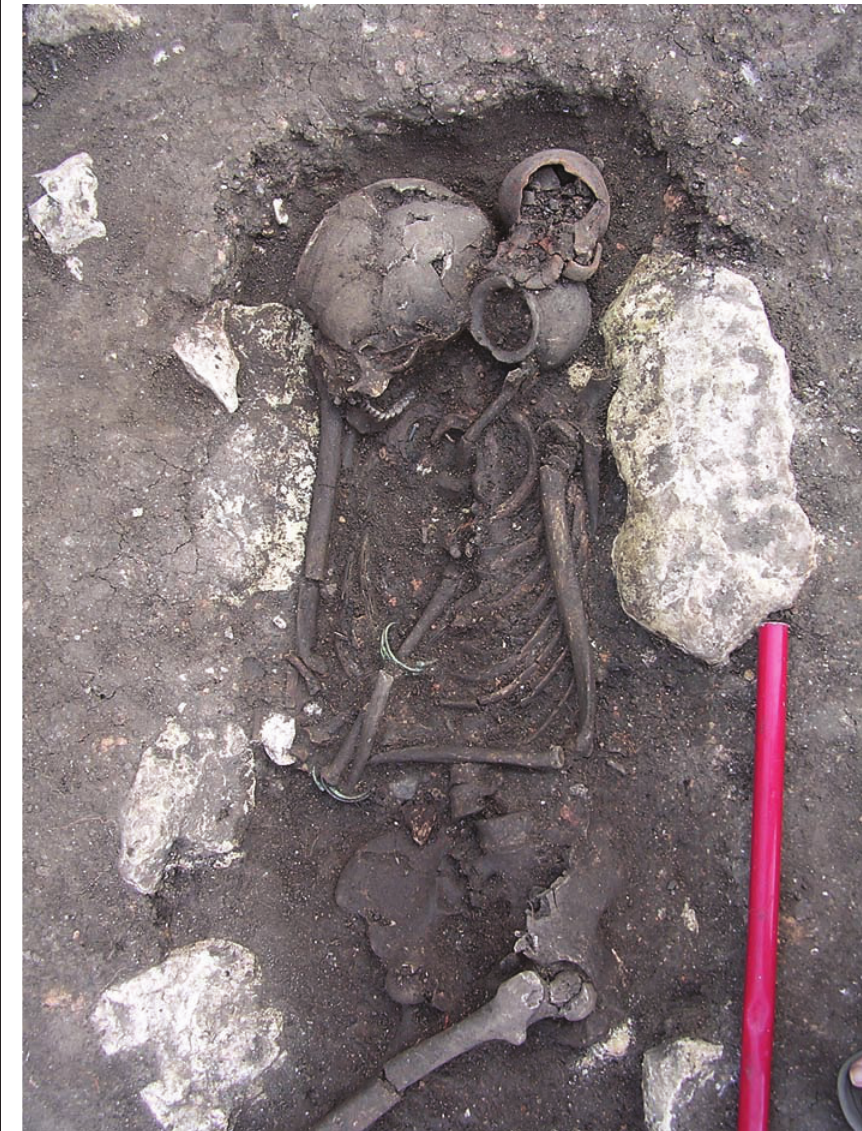
Figure 6 Adult female Hellenistic burial found in Trench A, excavated in 2007